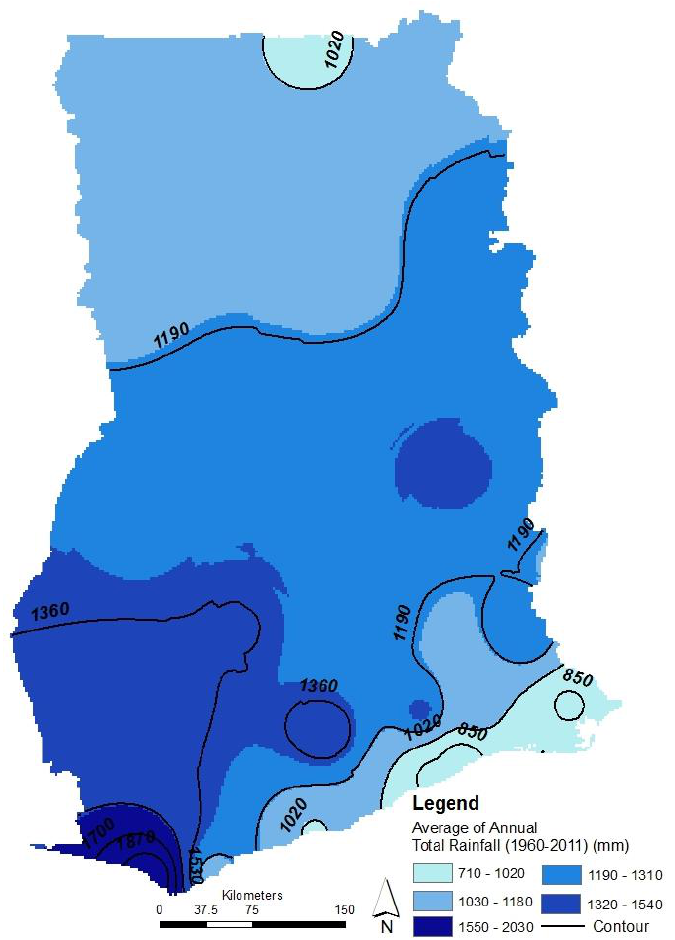
Figure 2. Spatial distribution of annual precipitation from 1960 to 2011. The Inverse Distance Weighting (IDW) approach was used to interpolate the rainfall data.